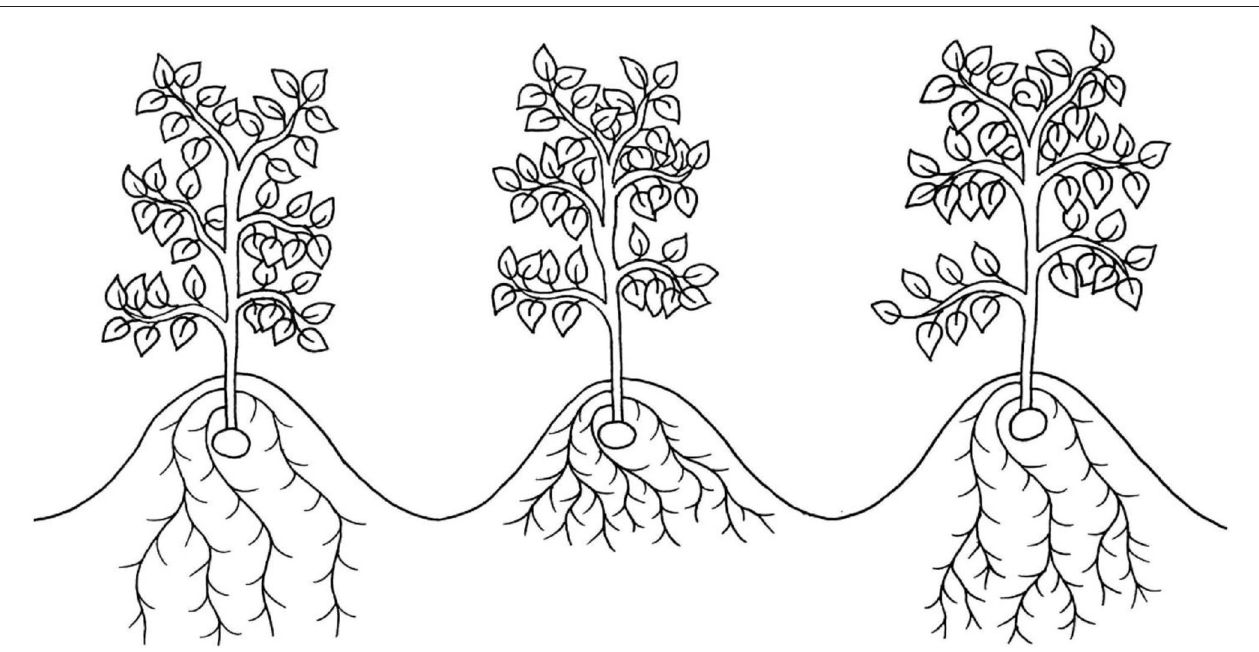
FIGURE 1 | An illustration of three root morphotypes which have been suggested to improve drought tolerance in potato: deep roots (left), dense roots in shallow soil strata (middle) and dense roots in deep soil strata (right).